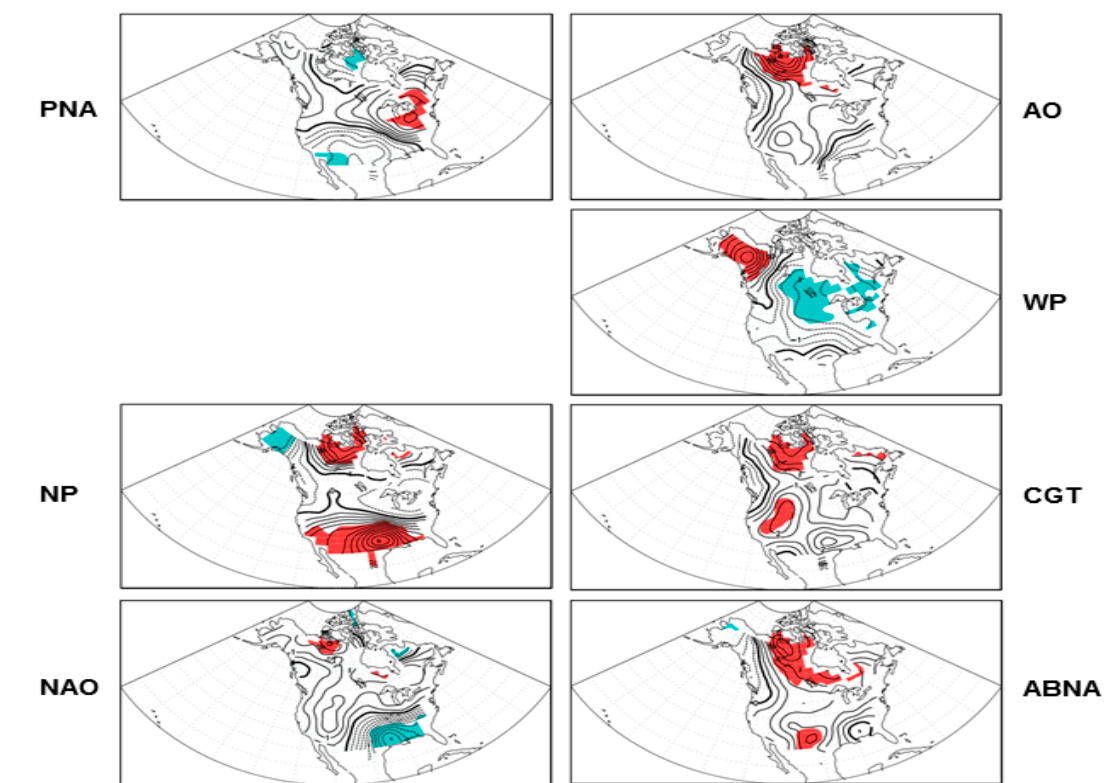
Figure 8. As in Figure 3, but for the JJA mean TX90p anomalies with contour interval